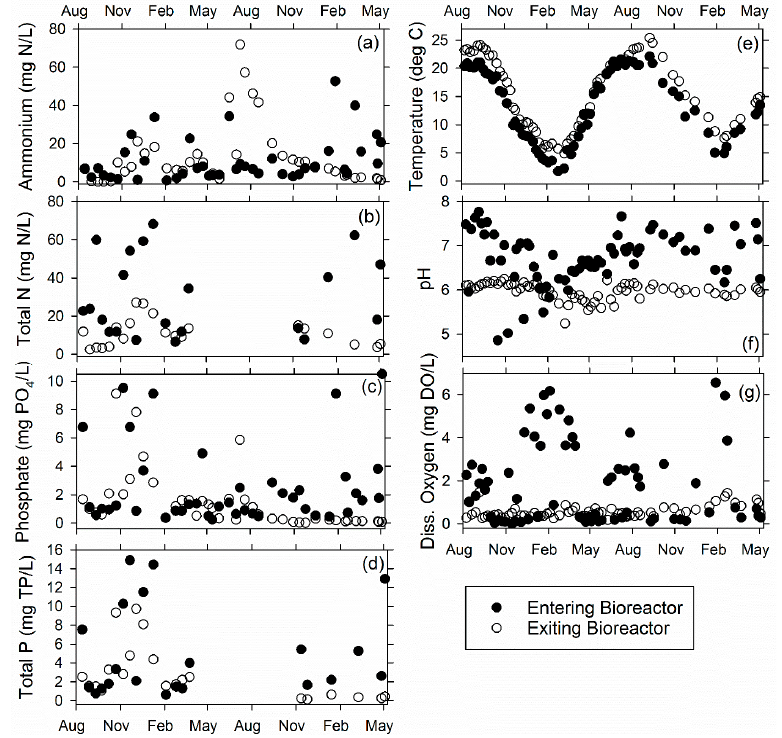
Figure 4. Ridgley Farm bioreactor ammonium (NH 4 ‐ N) ( a ); total nitrogen (TN) ( b ); phosphate (PO 4